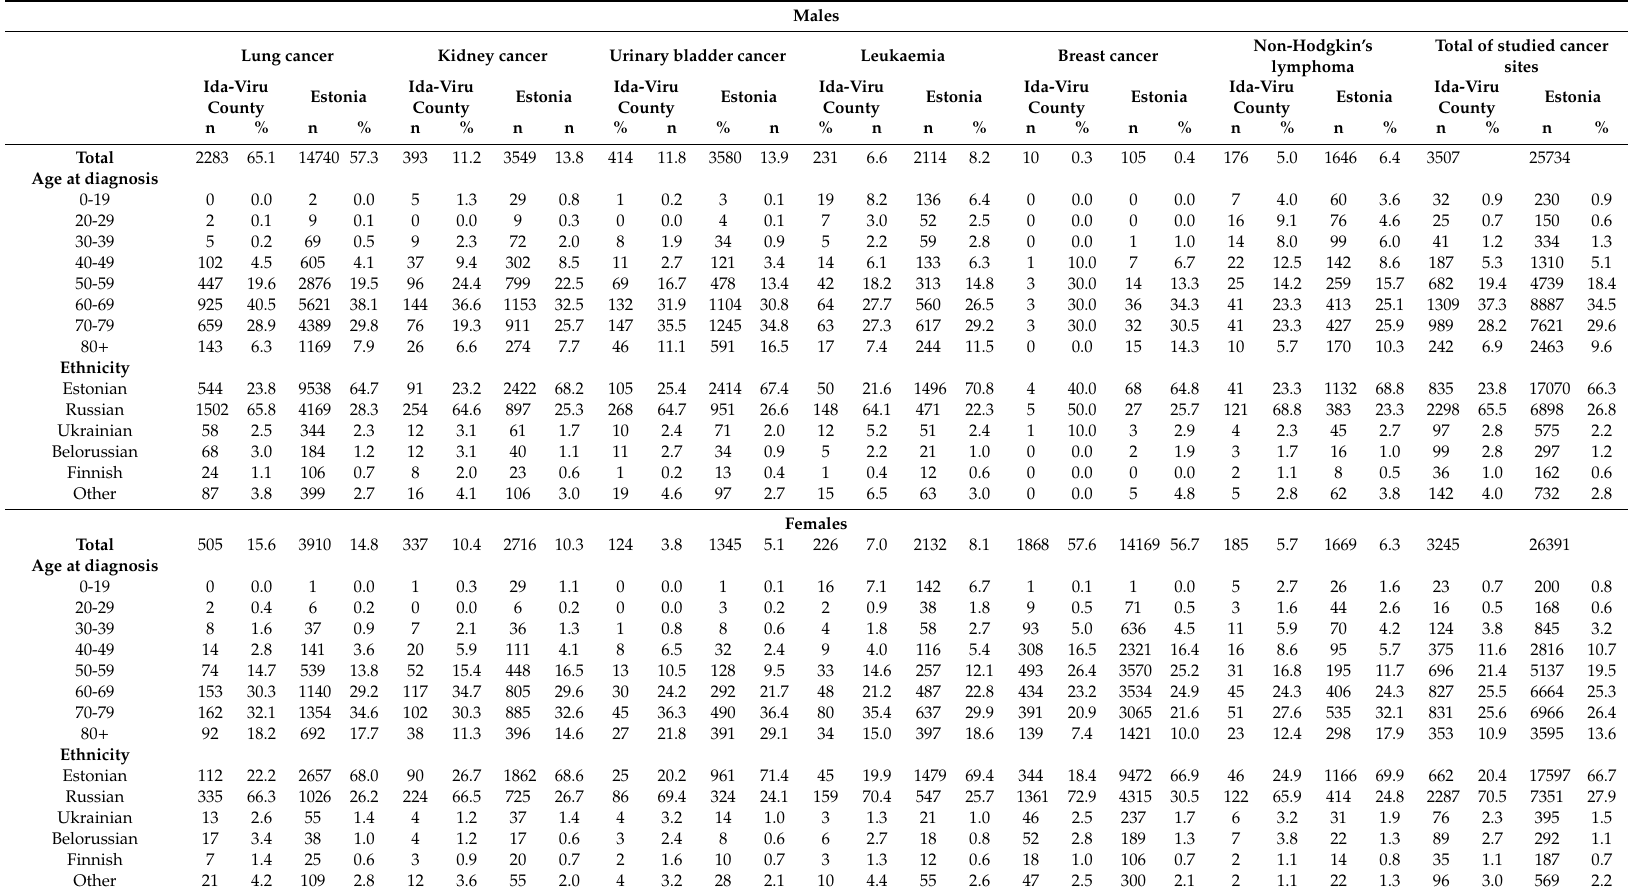
Table A1. Age and ethnicity of cancer incidence of the studied cancer sites according to the gender in Estonia and in Ida-Viru County in 1992–2015.